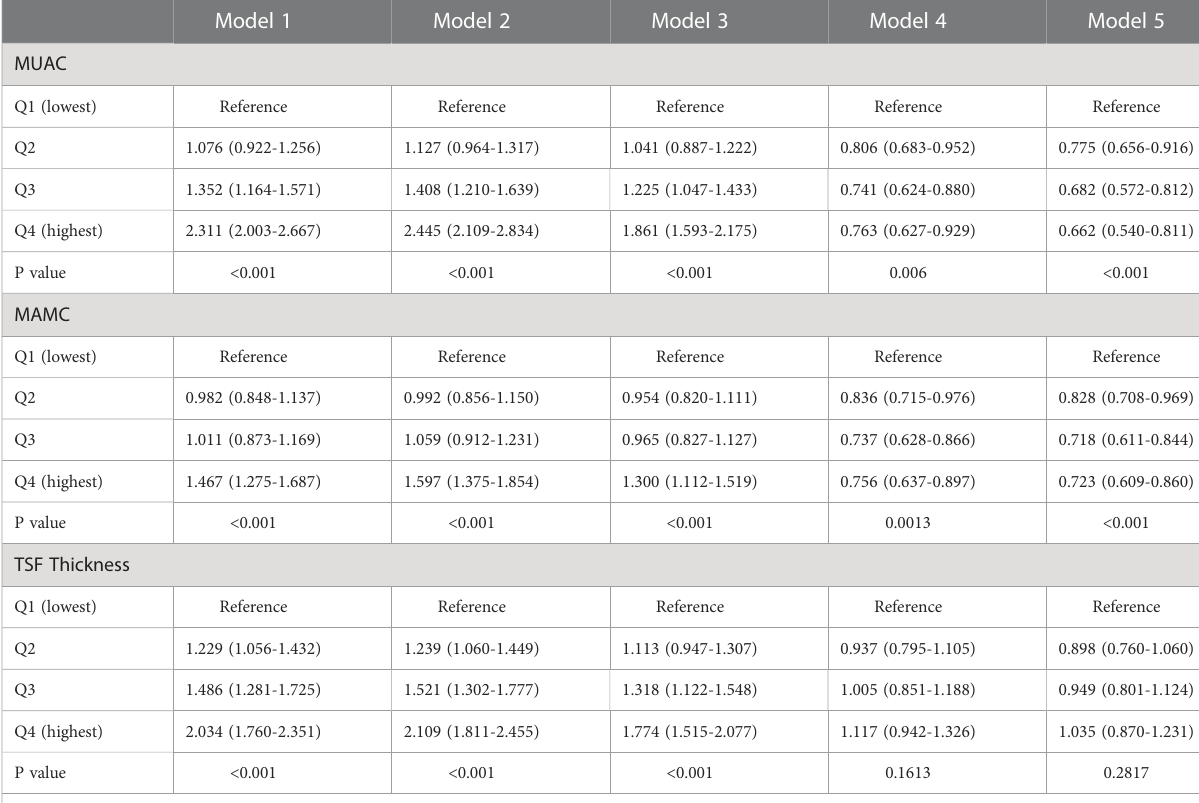
TABLE 2 Association between mid-upper measurements and insulin resistance in